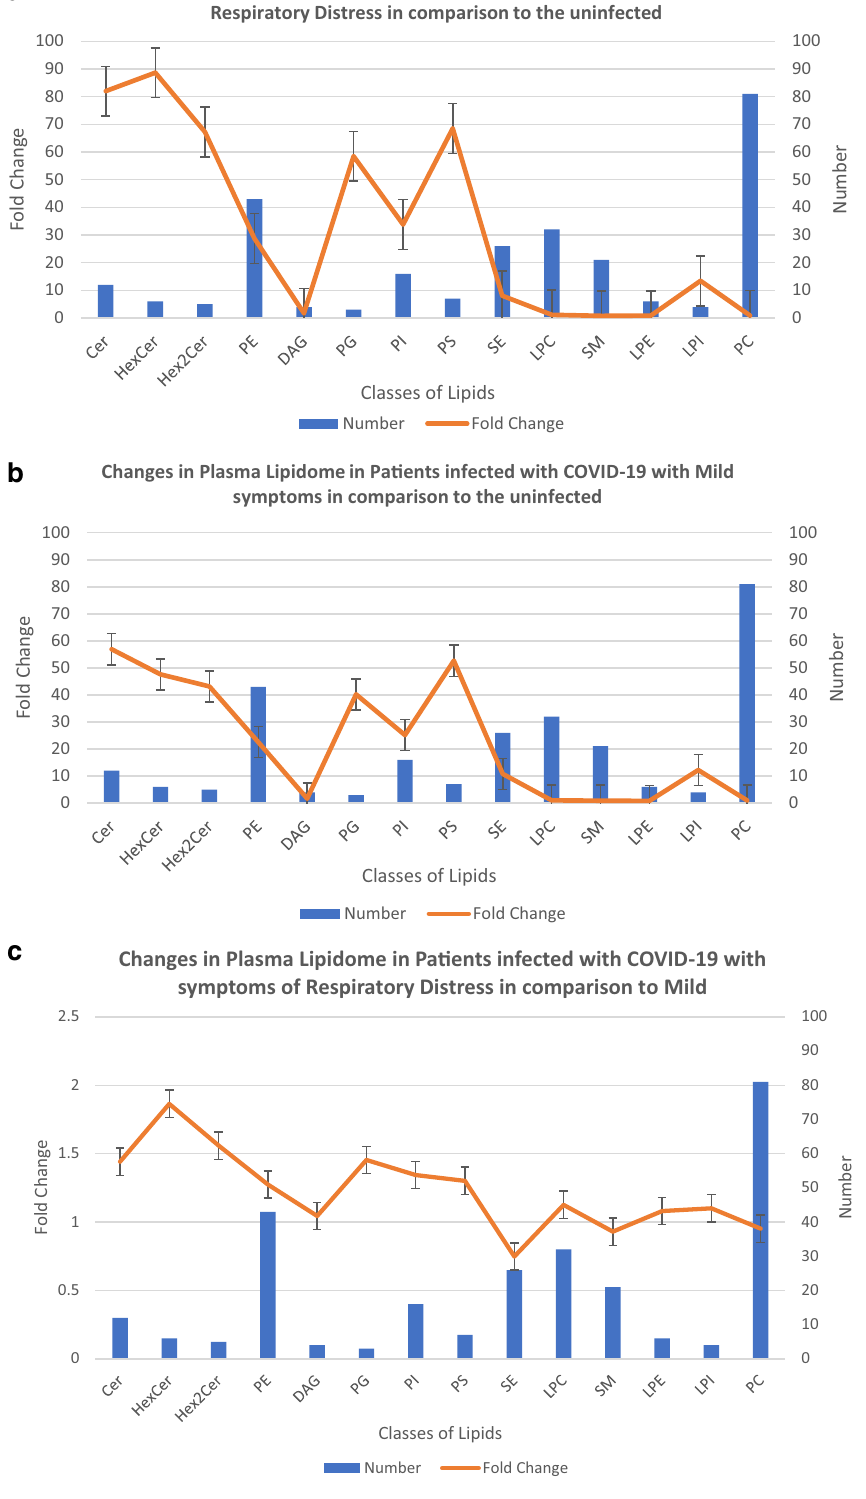
Figure 4. Effect of Covid-19 infection on Plasma Lipidome. Metabolites identified to be different lipid subclasses are segregated based on their class (X-axis), the number of members of each class identified in the plasma of COVID-19 infected individuals is represented (Y-axis). The fold sum of MEDM changes in peak areas, shows average change in levels of the identified lipid class as you go from the uninfected to infected with COVID-19 with respiratory distress symptoms ( a ), and to infected with mild symptoms ( b ). The comparative differences between the lipid classes in plasma of individuals with COVID-19 infection with mild vs respiratory distress symptoms are monitored ( c ). Error bars represent, standard deviation of